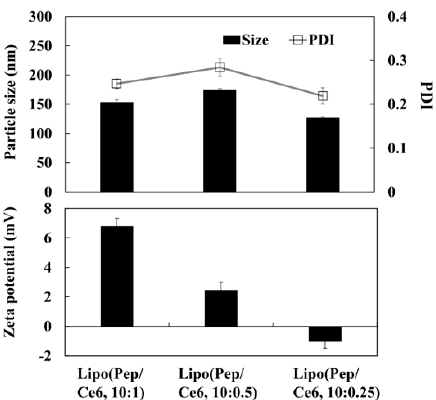
ff erent drug loading ratio ( w / w